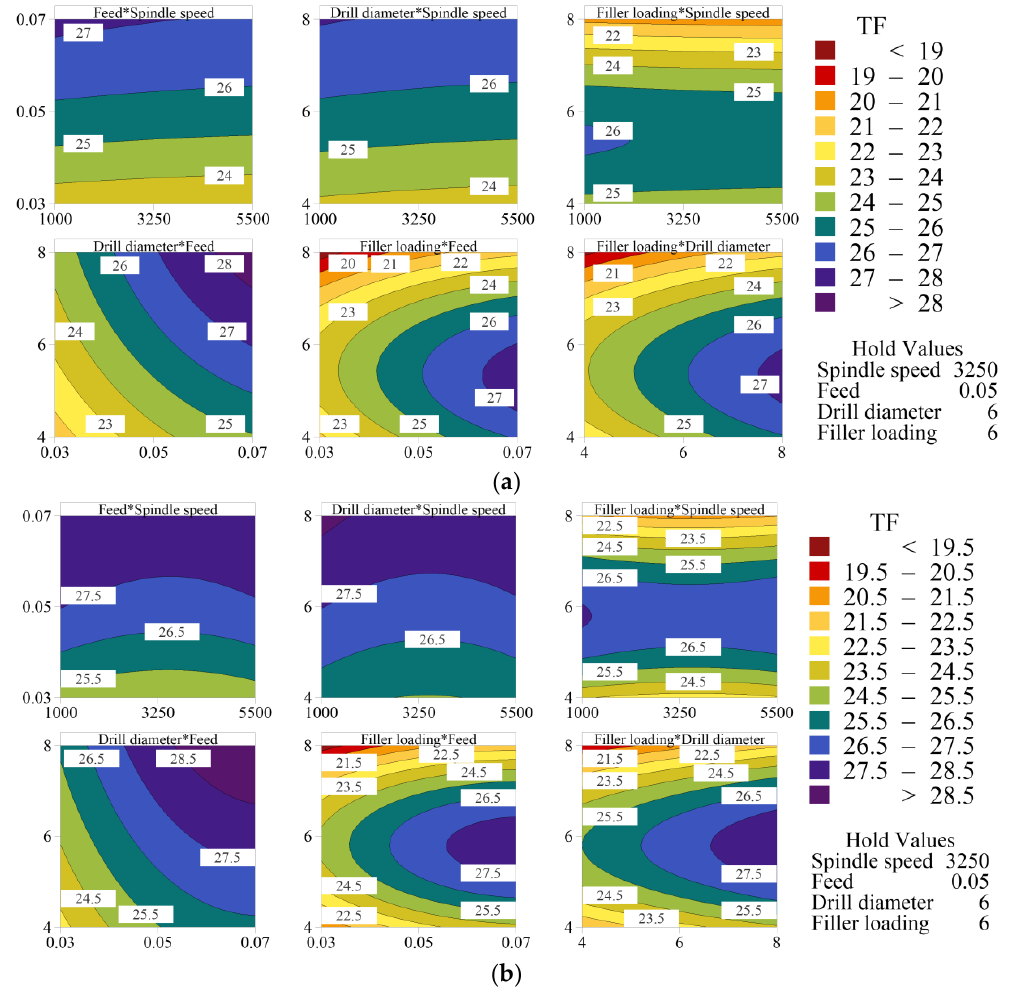
Figure 14. Contour plot of neat CEC ( a ) surface roughness and ( b ) delamination.